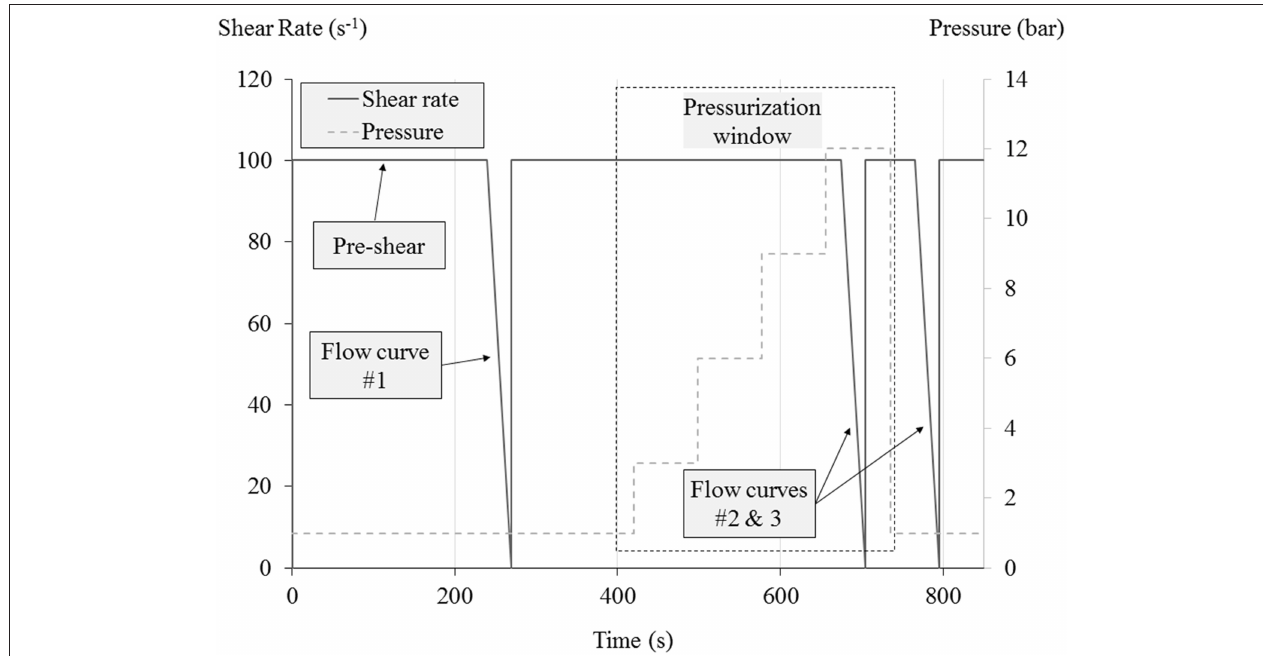
FIGURE 2 | Procedure A contained a constant shear at 100 s − 1 , with flow curves being determined before, during and after pressure. Pressure was applied in several stepwise increments during the pressurization window.